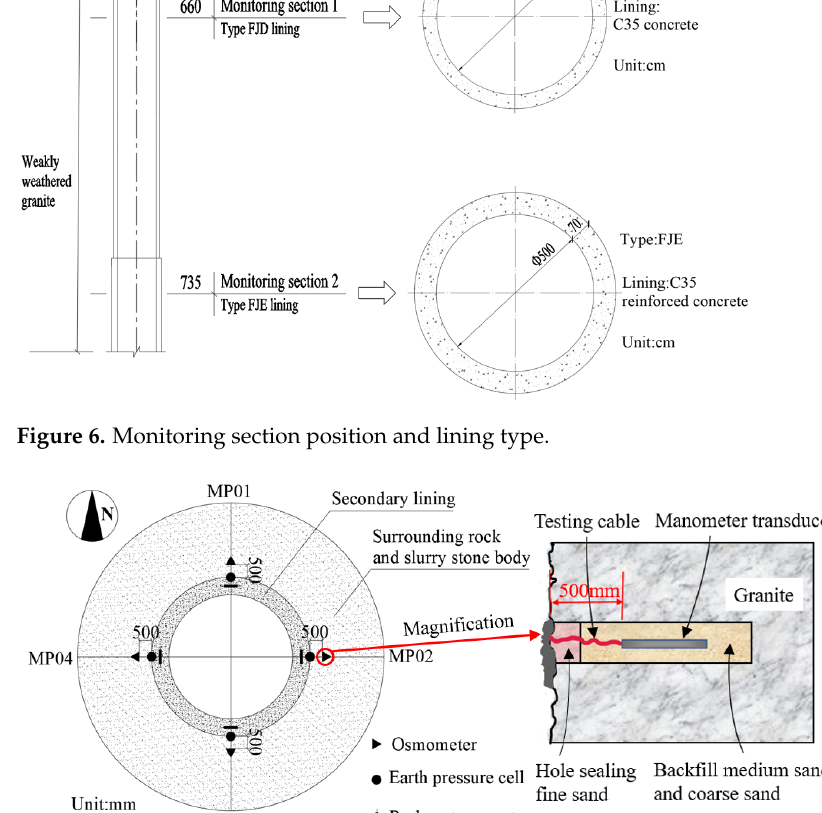
Figure 6. Monitoring section position and lining type.